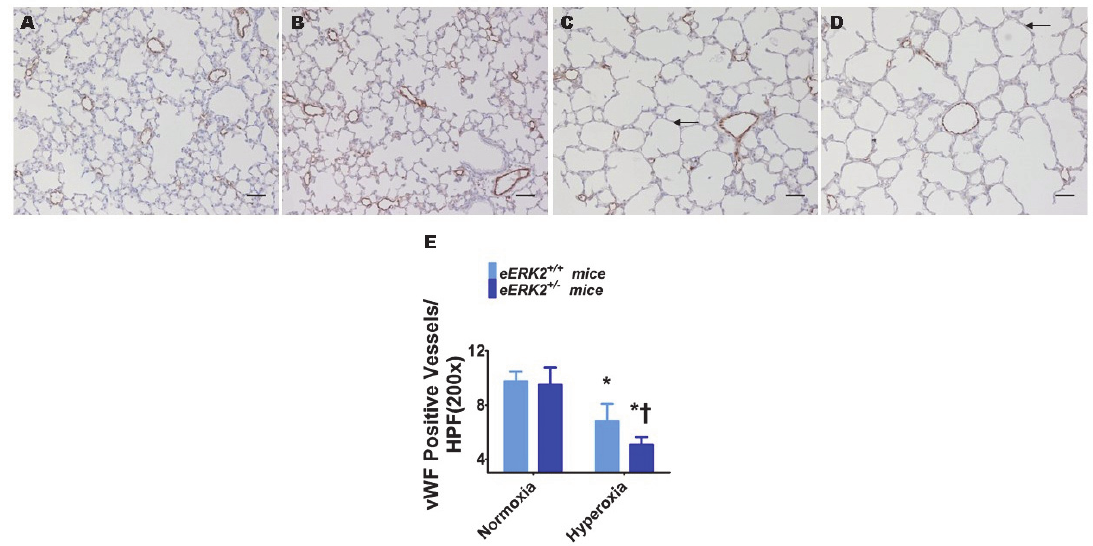
Figure 4. Lung vascularization in endothelial ERK2 -sufficient ( eERK2 +/+ ) or -deficient ( eERK2 +/ − ) mice exposed to hyperoxia. One-day-old eERK2 +/+ or eERK2 +/ − mice were exposed to either 21% O 2 (normoxia) or 70% O 2 (hyperoxia) for two weeks, after which the lungs were harvested for lung vascular morphometry. ( A – D ) Representative von Willebrand factor (vWF)-stained lung sections from eERK2 +/+ ( A , C ) and eERK2 +/ − ( B , D ) mice exposed to normoxia ( A , B ) or hyperoxia ( C , D ). Scale bar = 100 µm. ( E ) Quantitative analysis of vWF-stained lung blood vessels per high power field (HPF). Values are presented as the mean ± SD ( n = 4–5/genotype/exposure). Significant differences between eERK2 +/+ and eERK2 +/ − mice in hyperoxic conditions are indicated by †, p < 0.05. Significant differences between normoxia and hyperoxia groups are indicated by *, p < 0.05 (ANOVA).